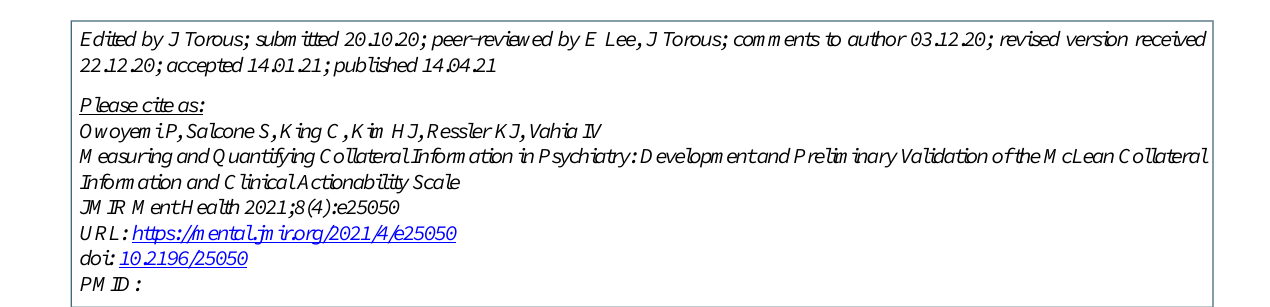
Abbreviations CIS: collateral information source EHR: electronic health record M-CICAS: McLean Collateral Information and Clinical Actionability Scale REDCap: Research Electronic Data Capture